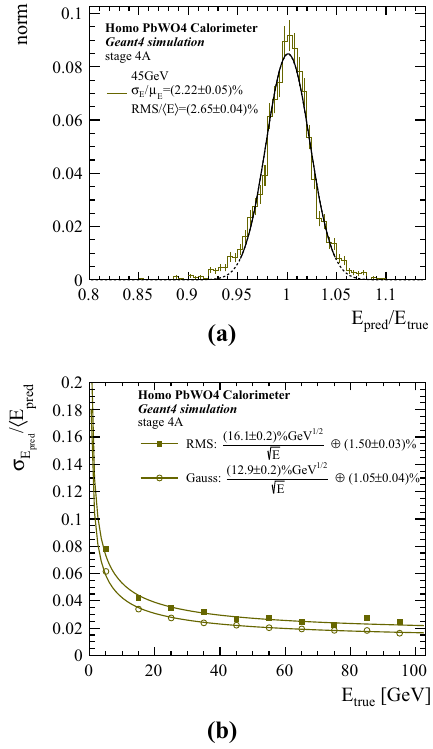
Fig. 1 Results for a scenario with 15 longitudinal layers (stage 4) and no transverse segmentation (stage A). a Energy distribution for 45GeV pions.ThewidthascomputedfromtheGaussianfit(blackline)andfrom the RMS are shown. b Energy resolution as a function of the particle energy. The resolution is computed two ways, using the Gaussian fit (open circles) and using the RMS (filled